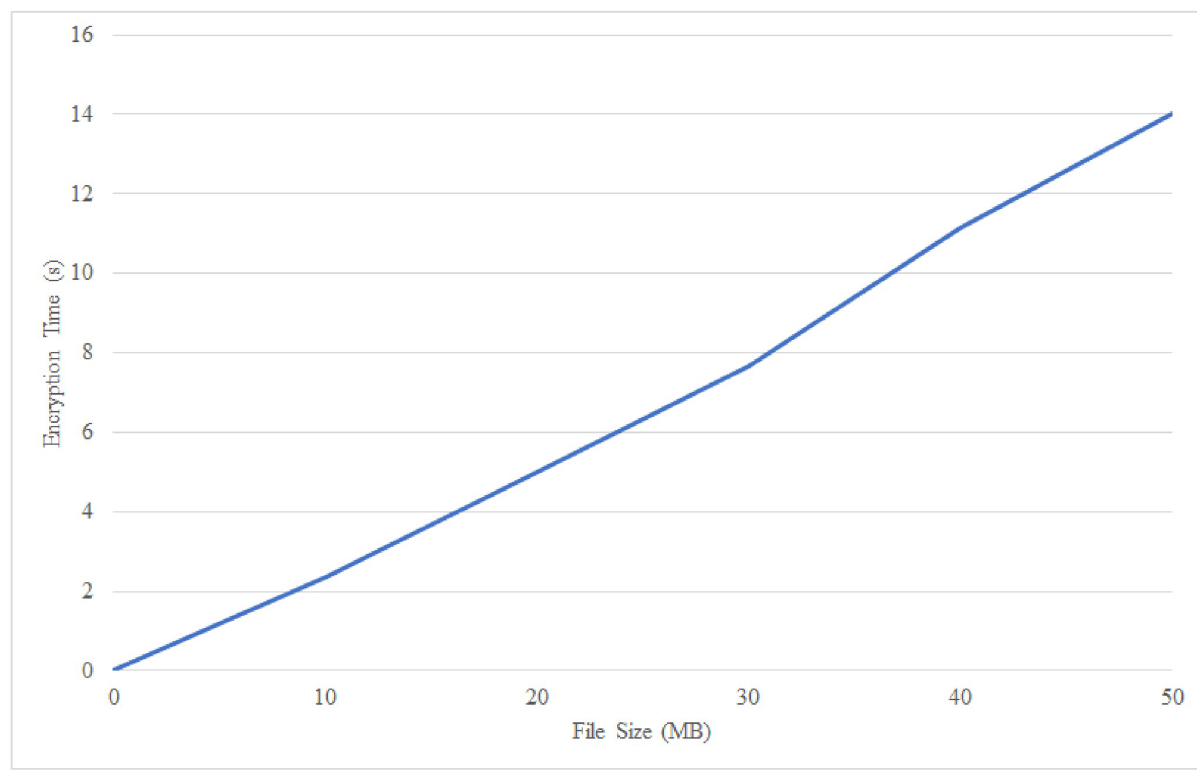
Fig 5. EHR encryption time based on different file